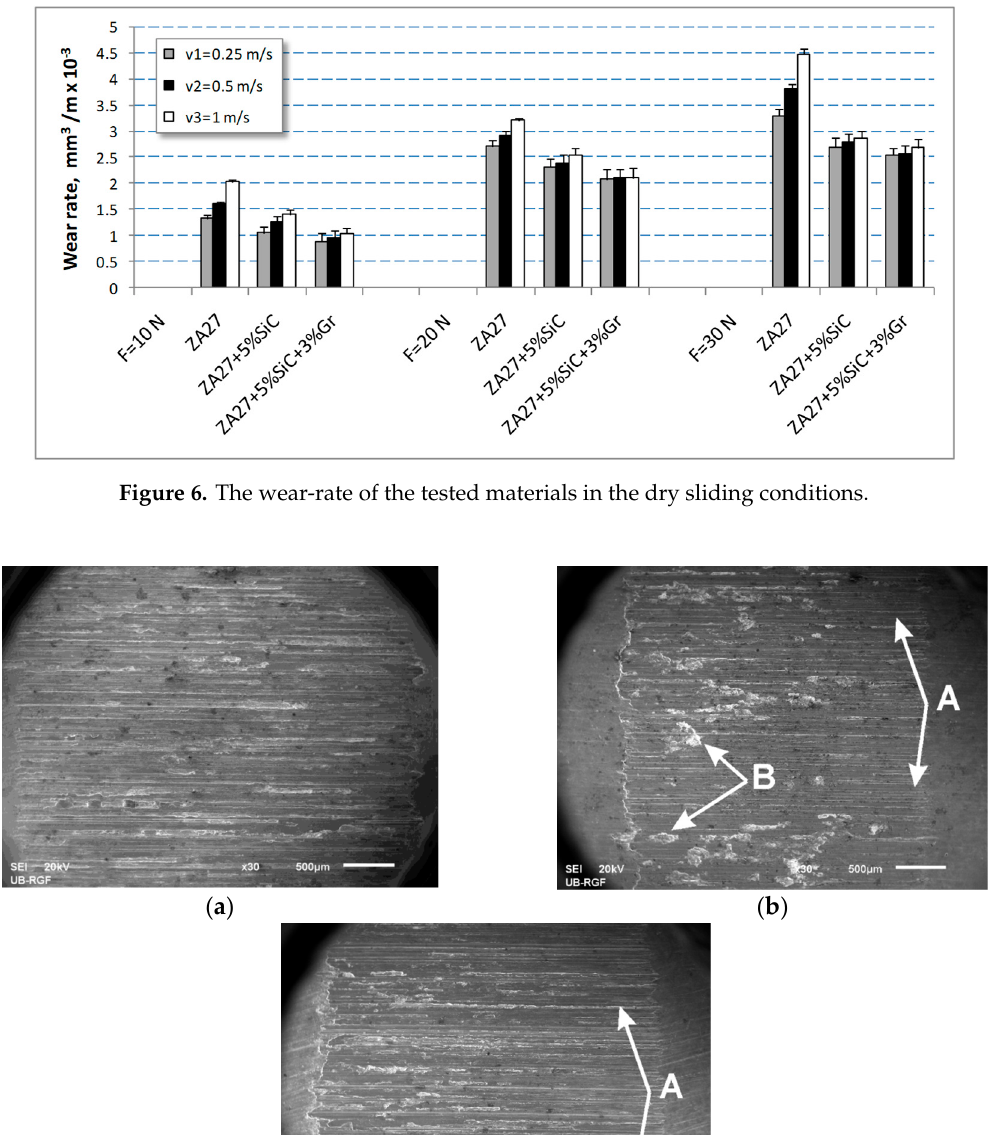
Figure 6. The wear-rate of the tested materials in the dry sliding conditions.